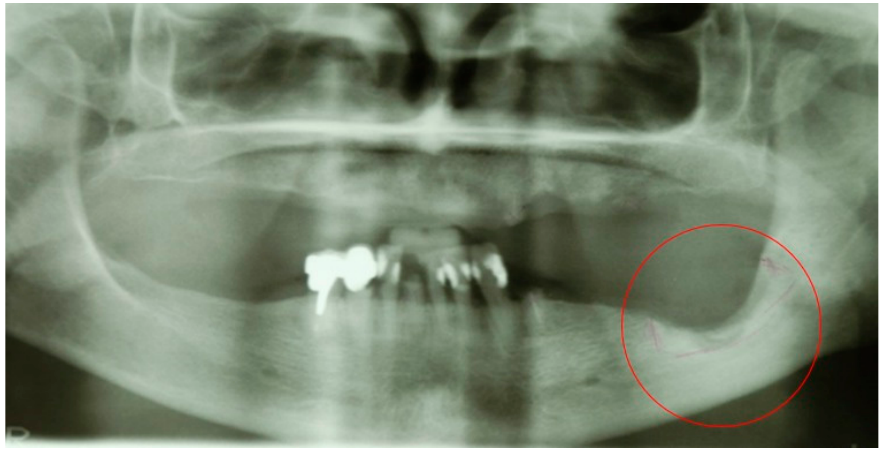
Figure 13. OPT of initial lesion pointed by the circle.